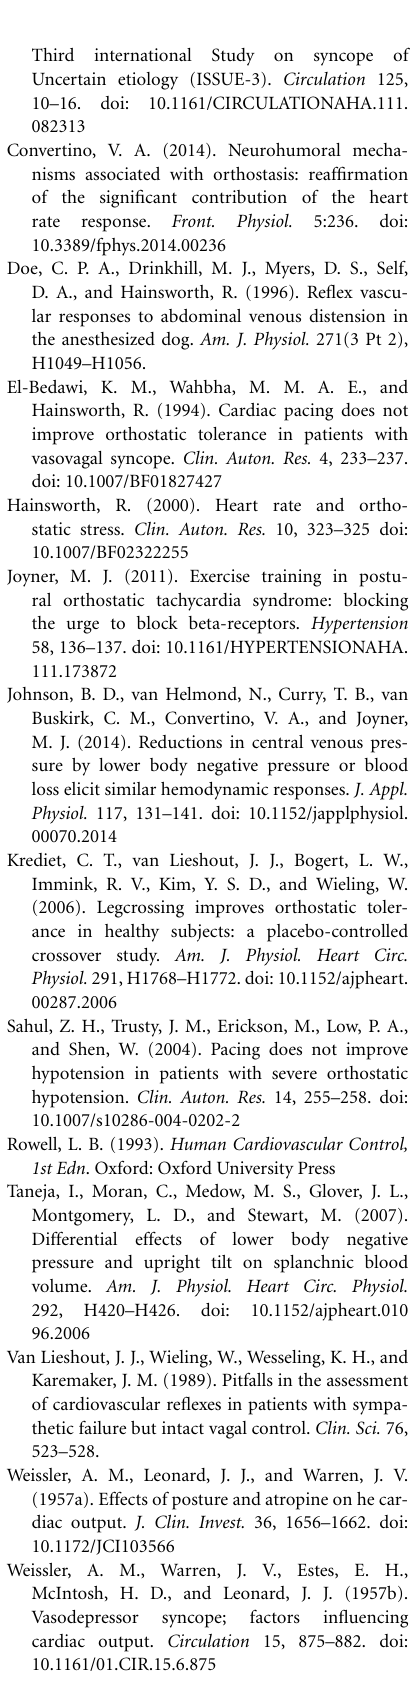
( Figure 1 , right panel) (Wieling and Karemaker,